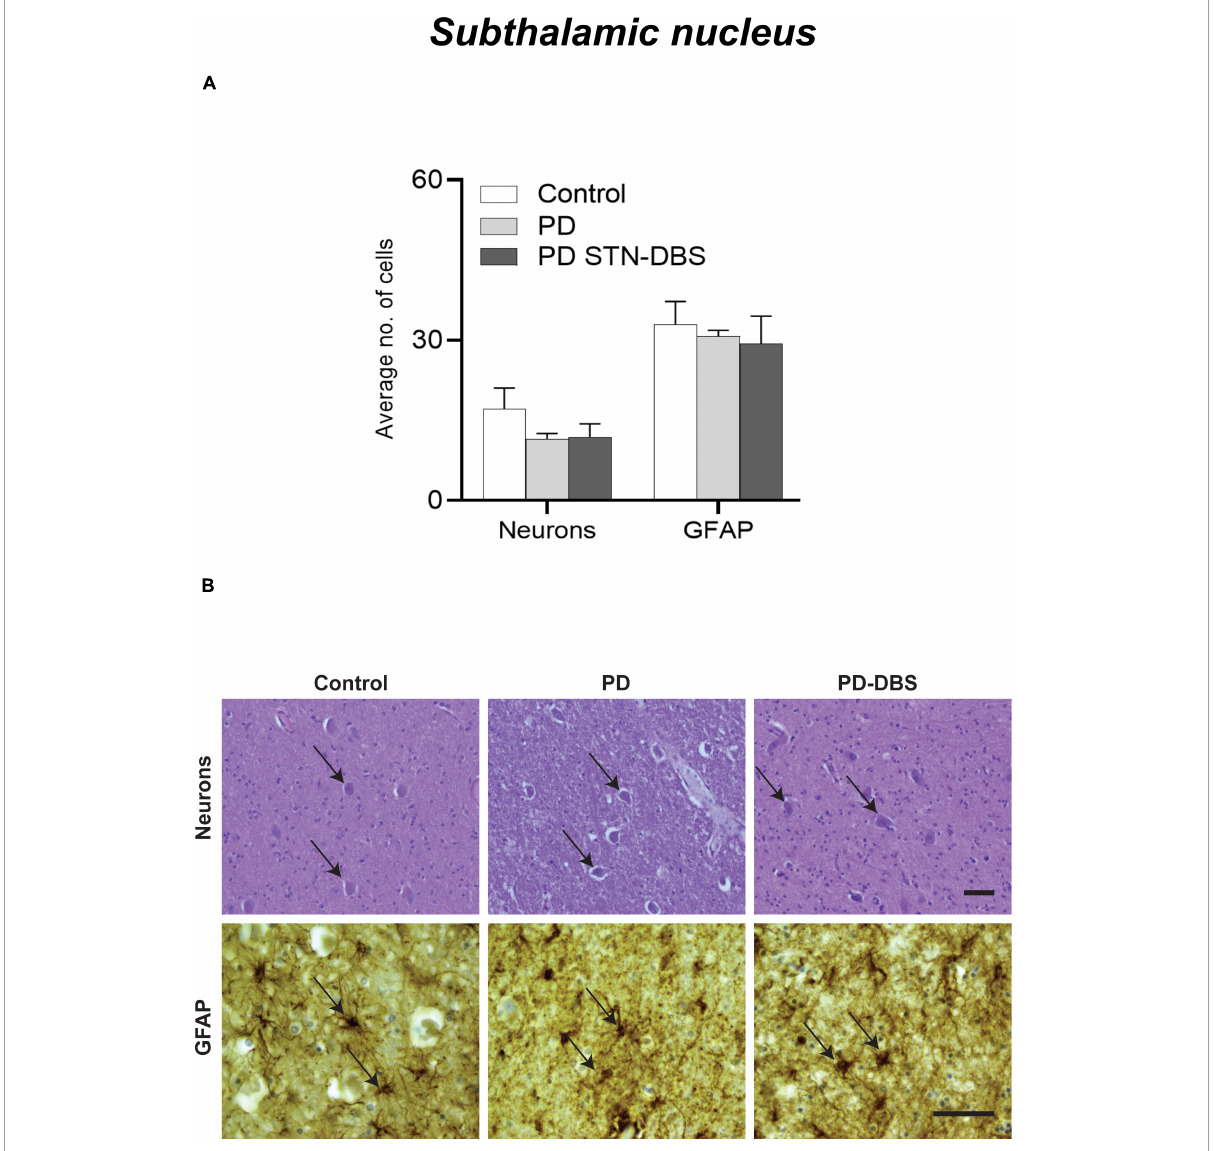
FIGURE2 Quantitation of neuronal loss and astrogliosis in the subthalamic nucleus (STN) of control, Parkinson’s disease (PD) and PD STN-DBS cases. (A) Between control and PD patients no significant difference was observed in neuronal ( p = 0.358) or inflammatory marker (GFAP: p = 0.612). (B) Representative photomicrographs of neuronal density (black arrow showing H&E stained neuron), GFAP (black arrow showing astrocyte) in control, PD, and PD STN-DBS patients in the STN. All values are expressed as mean ± SEM. Scale bar = 50